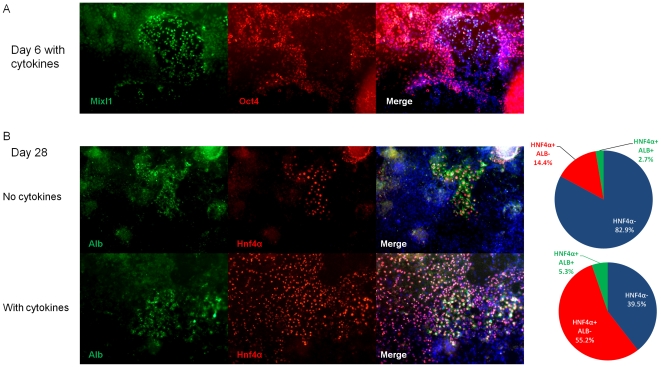
Immunofluorescence assessment mESC progeny (n = 3).[A] Presence of Oct4−/Mixl1+ cells on day 6, only in the presence of additional growth factors. In the condition without growth factors, no Oct4−/Mixl1+ cells could be observed (data not shown). [B] Presence of Hnf4α+/Alb+ cells on day 20, was significantly higher in the condition with additional growth factors, as quantified in the pie-charts.